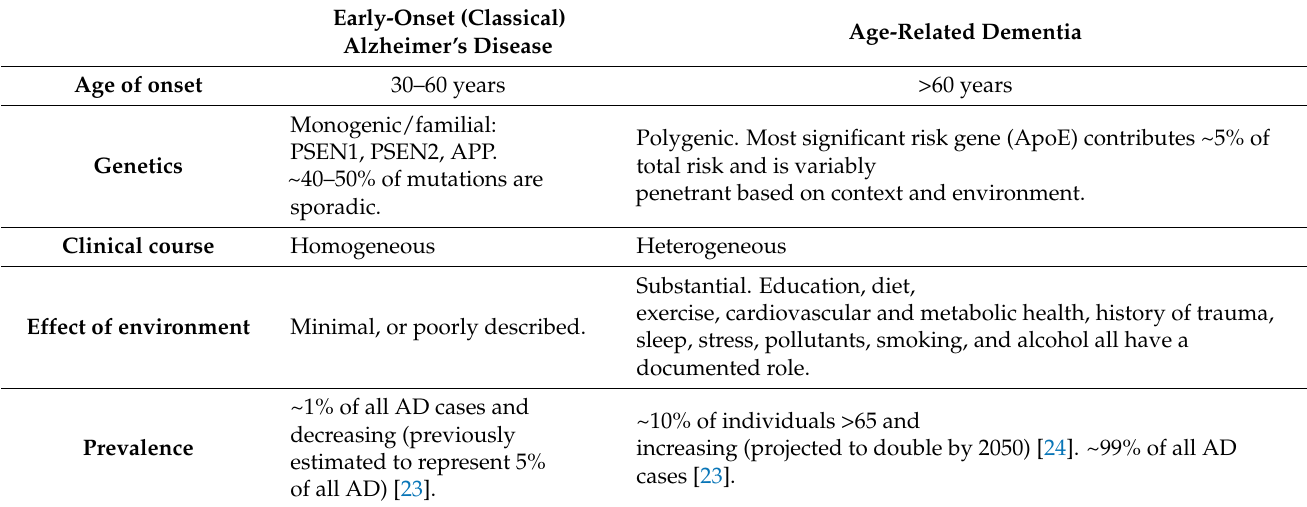
Table 1. Comparison of classical AD and ARCD based on clinical course and risk factors. When examining the background and clinical course of classical AD and ARD, it becomes clear that they describe entirely different disease processes that should be considered separately.